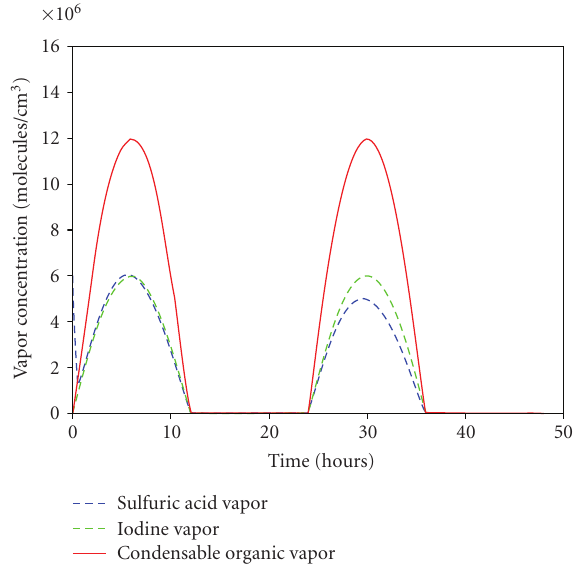
Figure 1: Concentrations of vapour species taken over 48 hours of simulation